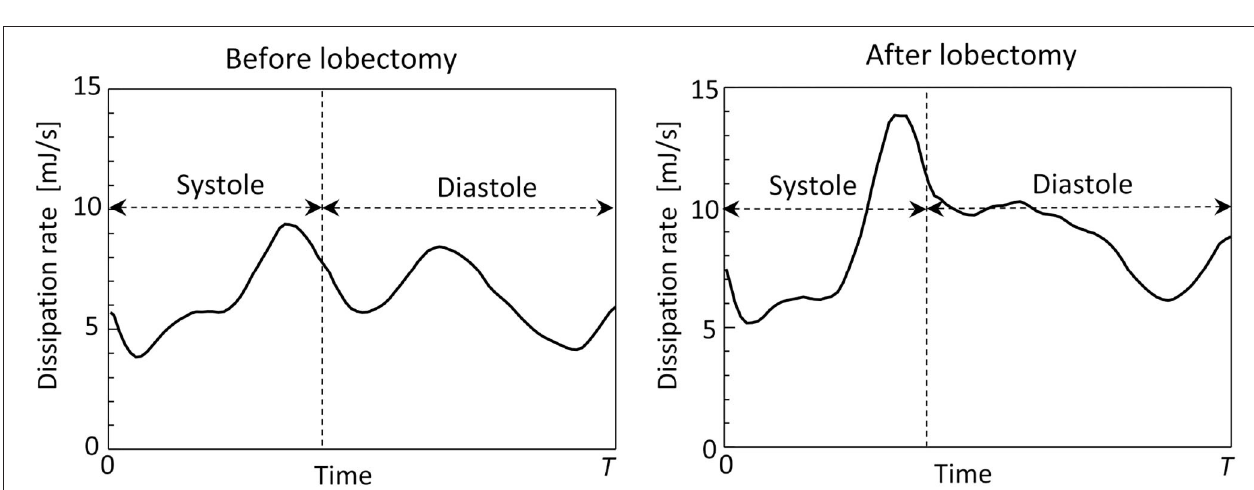
FIGURE 9 | Time courses of the viscous dissipation rate in the left atrium throughout the cardiac cycle, before and after the left upper lobectomy ( T : cardiac cycle from